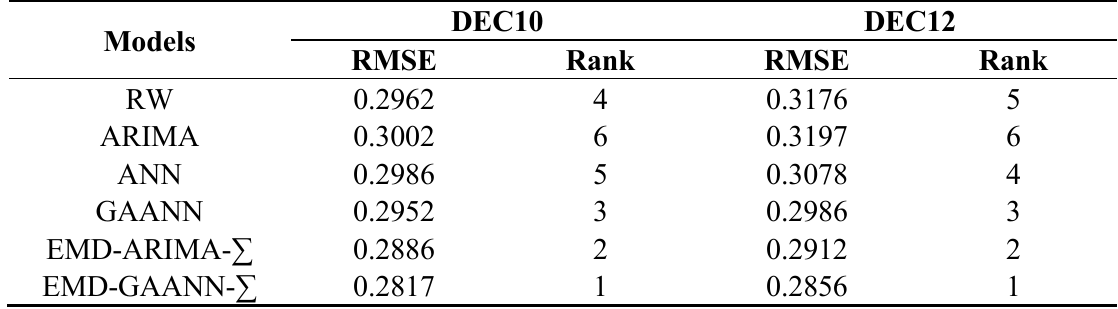
Table 3. RMSE comparisons for different forecasting models.